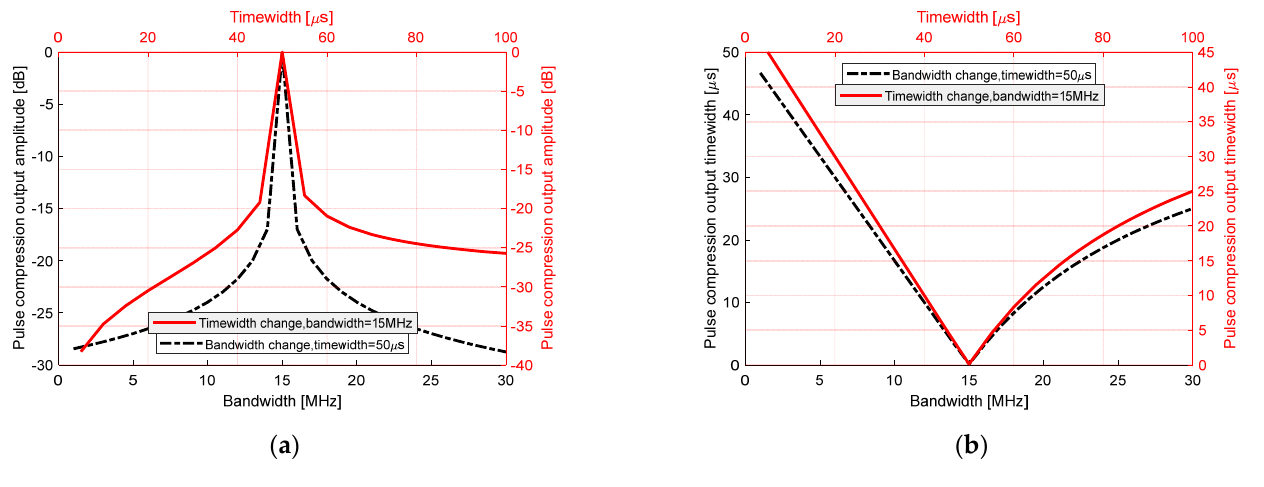
Figure 7. The effect of bandwidth change, time width = 50 us and time width change, bandwidth = 15 MHz on pulse compression output peak value ( a ) and effective time width ( b ) of FM rate mismatch signal.